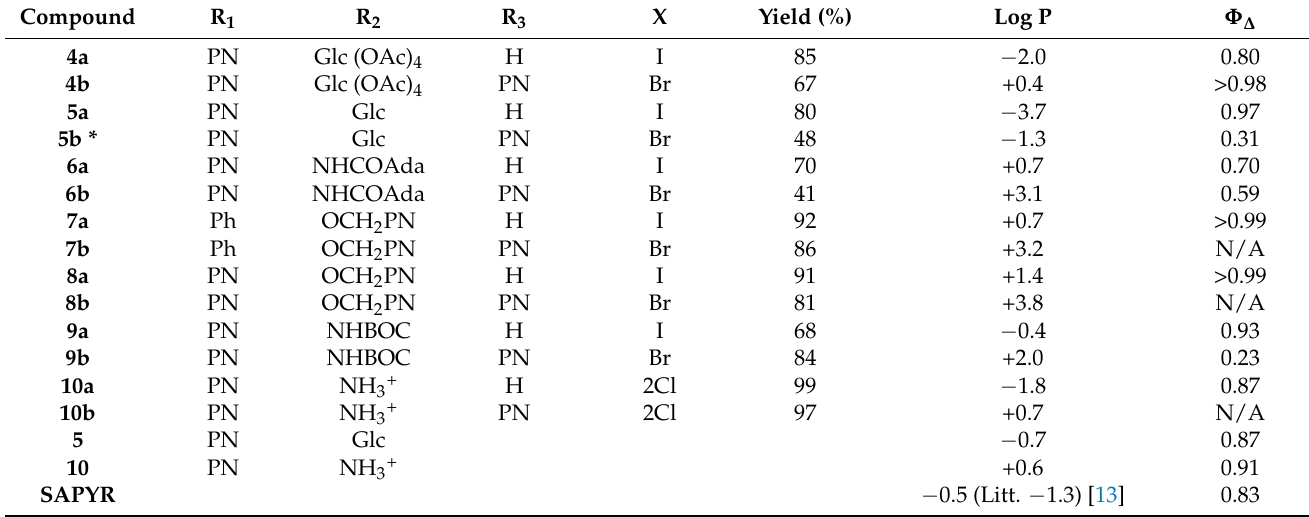
Table 1. Structure of the triazolium salts, yield of alkylation or deprotection, partition coefficients (log P) calculated at pH = 7.3, and singlet oxygen quantum yields ( Φ∆ ) in H 2 O based on 1 H -phenalene-1-one-2-sulfonic acid (PNS) [22] with Φ∆ = 0.97 as a reference. For all chemical structures see Figure S49 in Supplementary Materials. Compound R 1